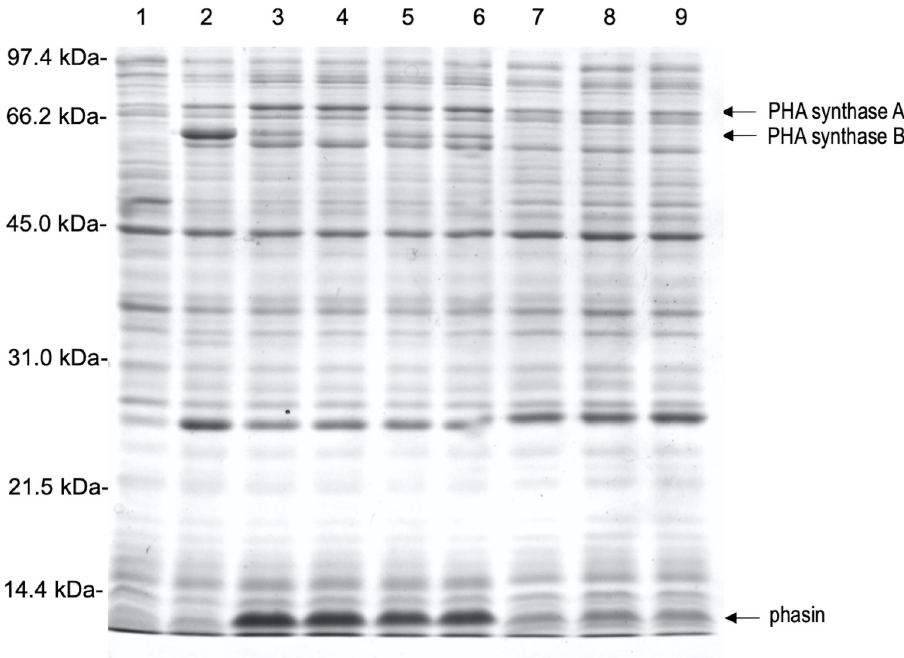
Fig 4. Expression of wildtype and mutant B-18 PHA genes using runaway replication in E . coli XL1-Blue. Samples 1: (pDKF2) 30˚C, 2: (pDKF2) 41˚C, 3: (pDKE6) 41˚C, 4: (pDK108) 41˚C, 5: (pDK201) 41˚C, 6: (pDK401) 41˚C, 7: (pDK603) 41˚C, 8: (pDK702) 41˚C and 9: (pDK802) 41˚C. All samples were incubated 3 hours past the induction point. The sample volume was adjusted so that each lane contained the same amount of protein. The arrows indicate the probable location of PHA synthase (67.306 kDa or 62.675 kDa depending upon the location of the translational start) and the phasin (13.153 kDa predicted size).